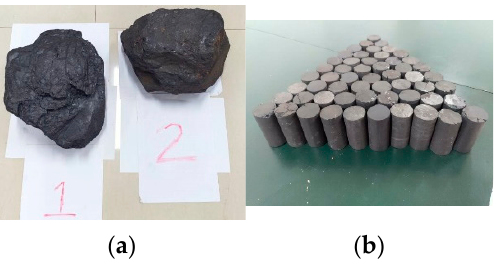
Figure 1. Initial materials and molded samples. ( a ) Initial materials. ( b ) Molded samples. Two kinds of samples were created. The samples with a bedding angle of 0° were used to take the uniaxial compression tests and the triaxial compression tests, while the samples with bedding angles of 0°, 30°, 45°, 60°, 75° and 90° were used to analyze the mechanical behavior influence of the coal under the triaxial condition. The samples were obtained through different drilling angles, as shown in Figure 2.